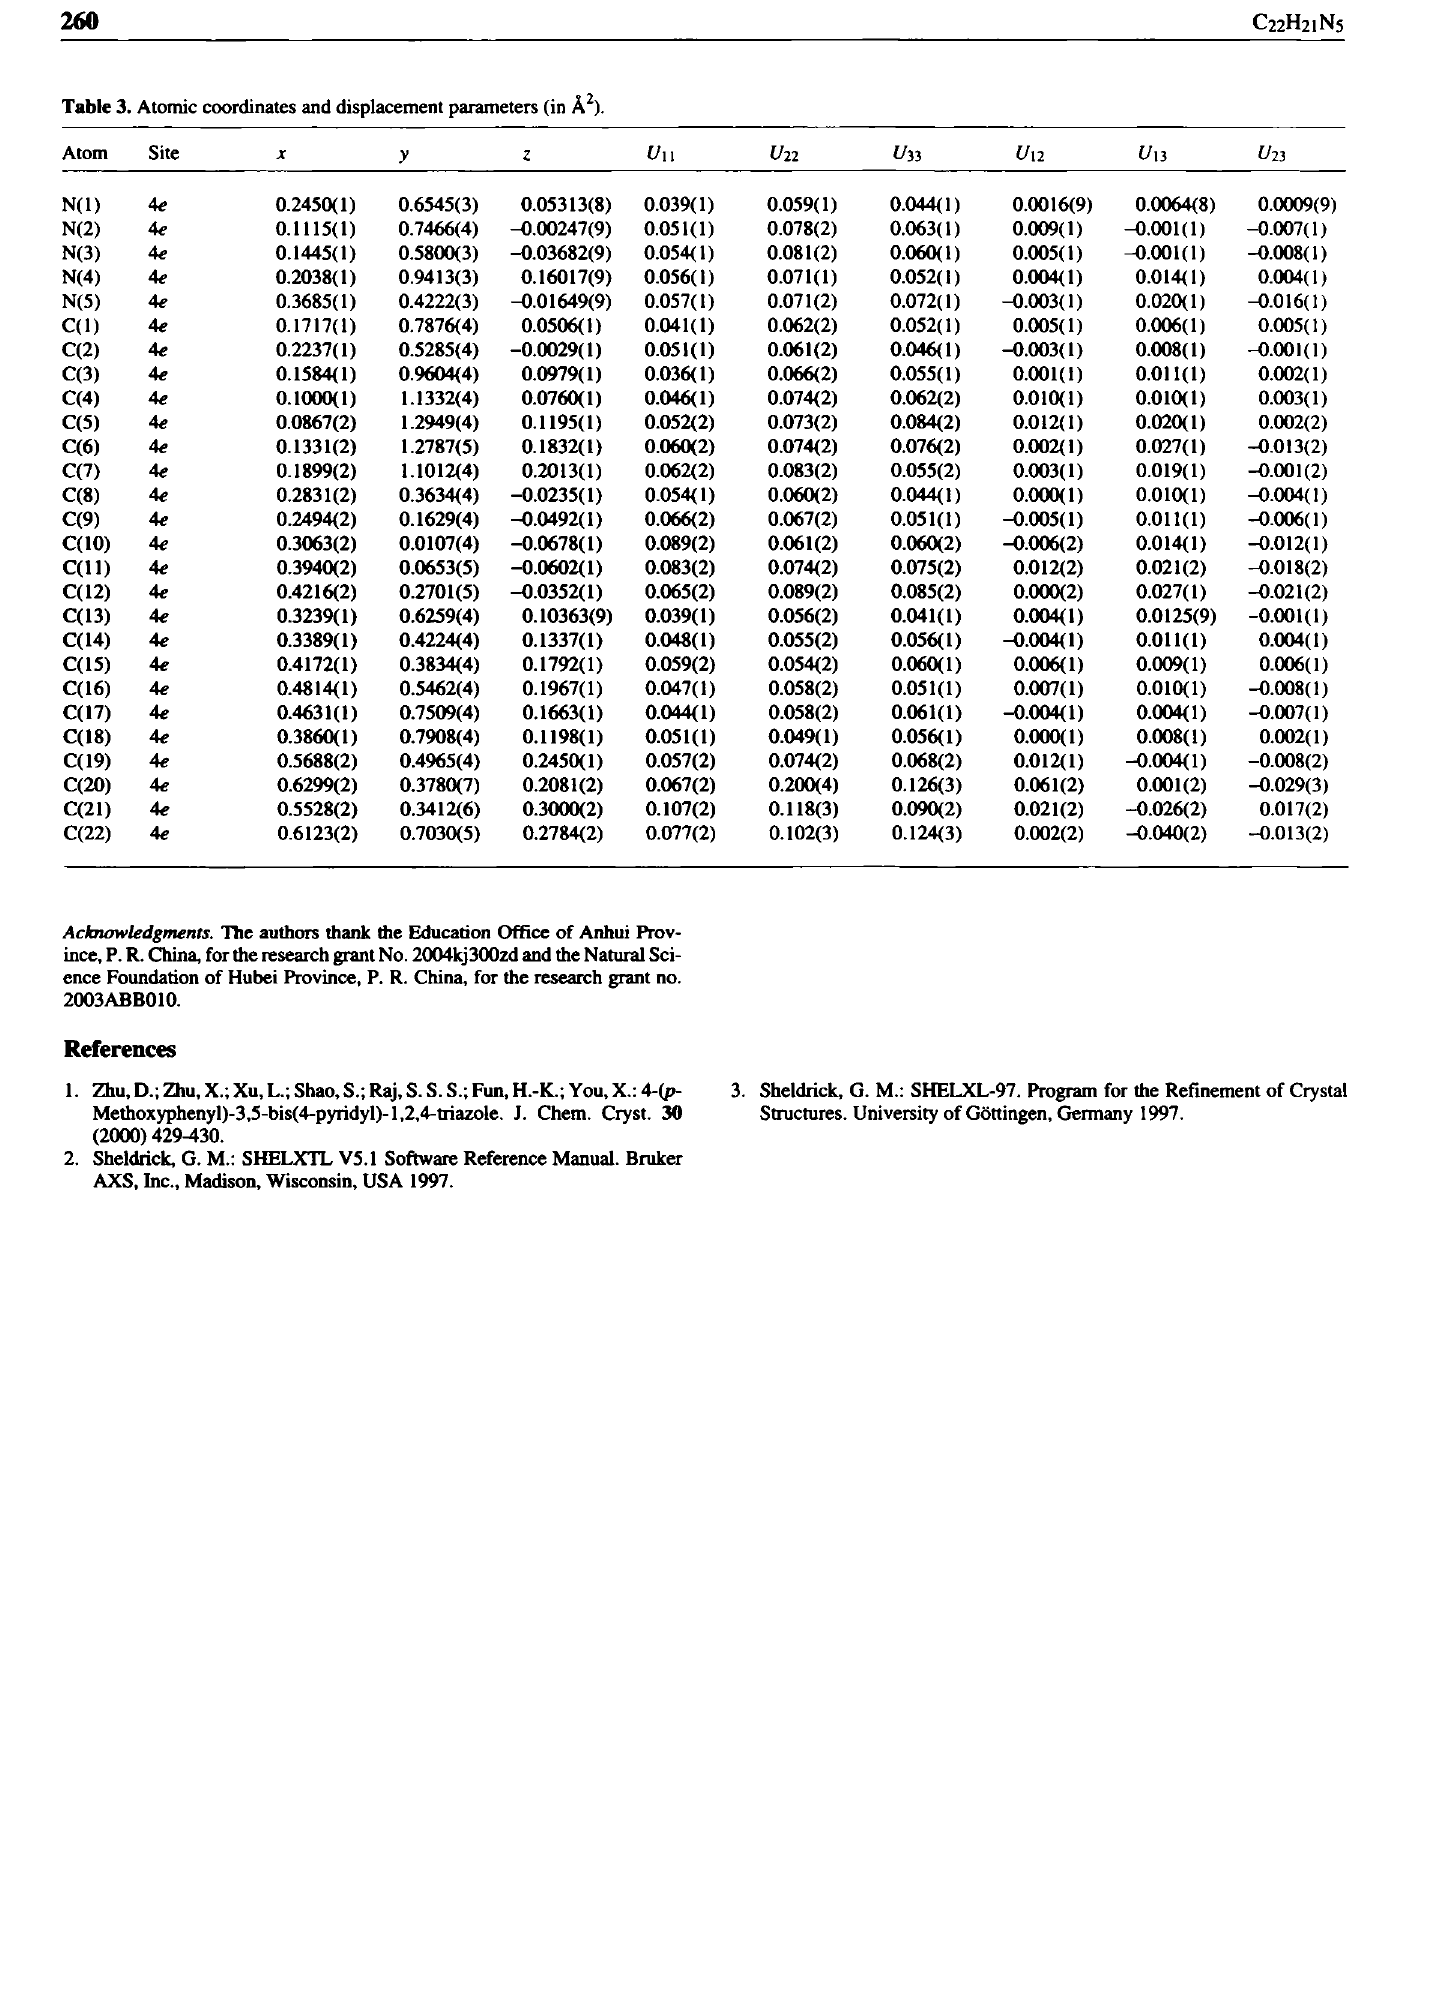
Table 3. Atomic coordinates and displacement parameters (in Â 2